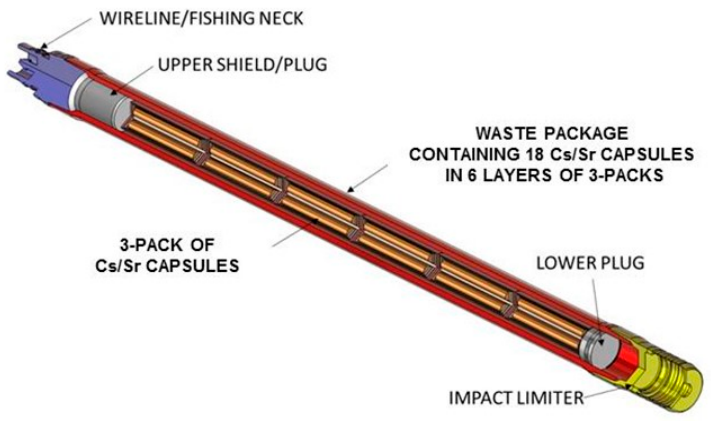
Figure 3. Schematic of a waste package (WP) for Cs/Sr capsules. Source: Freeze et al. [5].